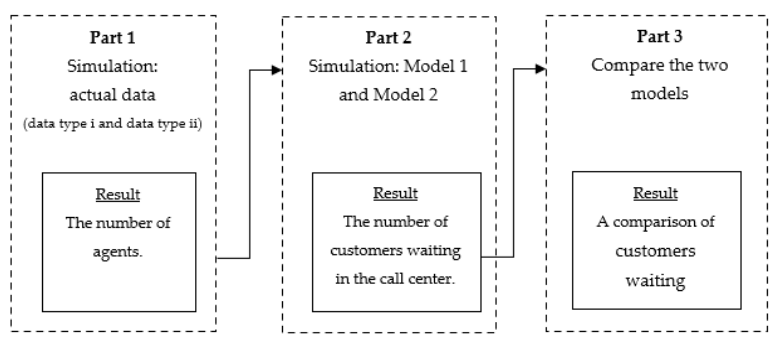
Figure 5. Process of configuring data for simulation.